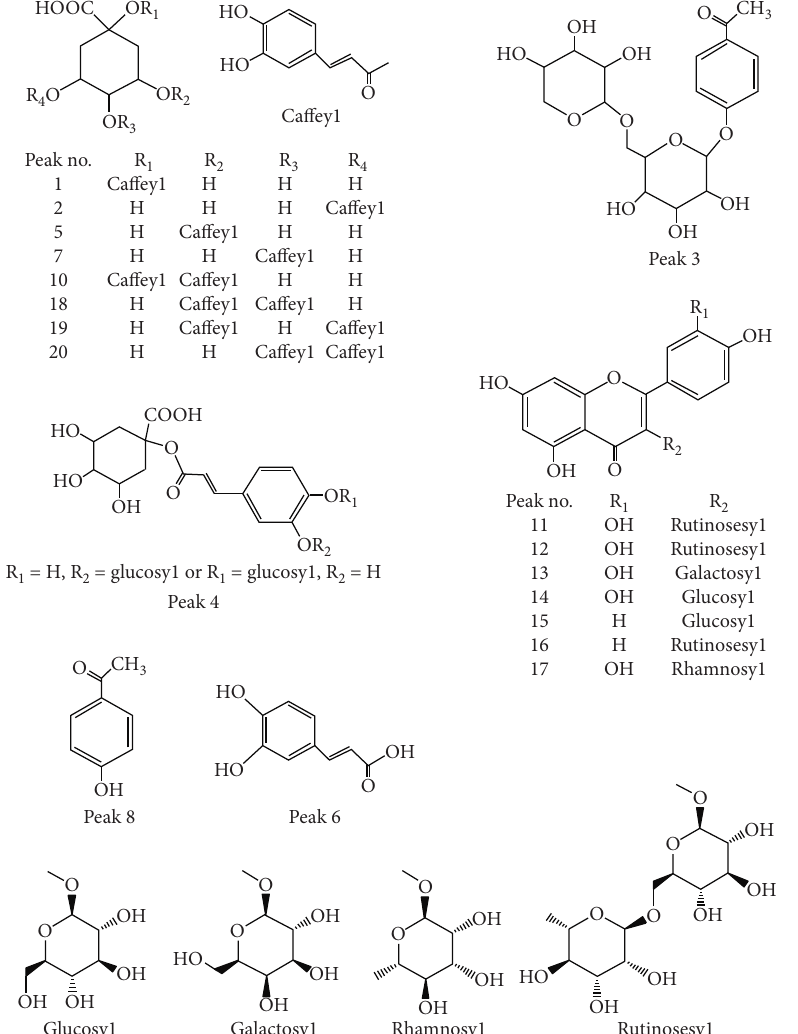
Figure 4: Structures or possible structures of the components of peaks 1–8 and peaks